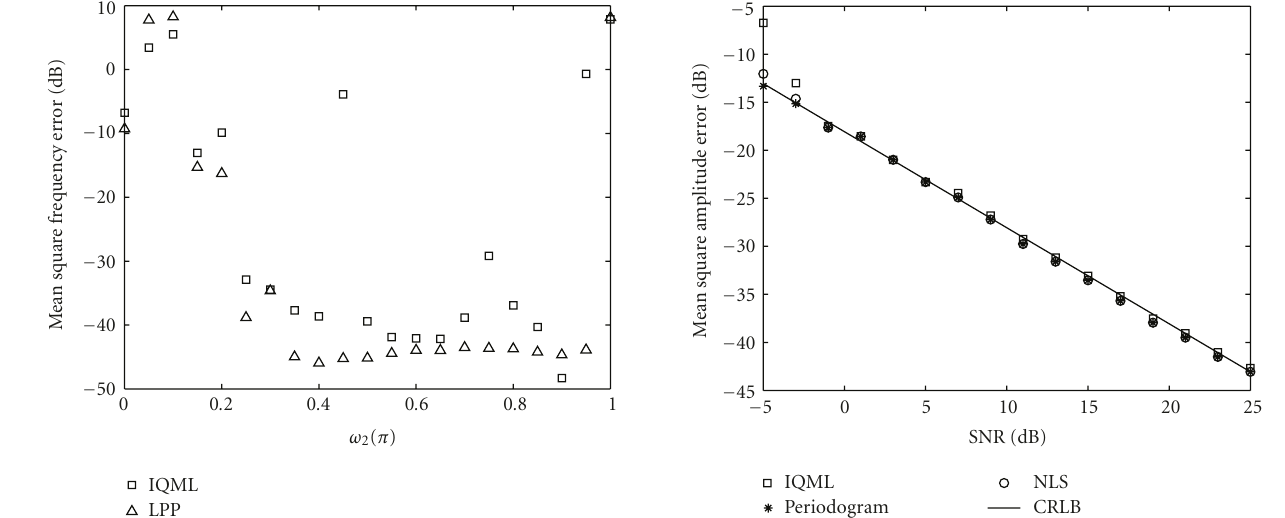
Figure 22: MSE for ω 1 of multiple complex sinusoids versus ω 2 .